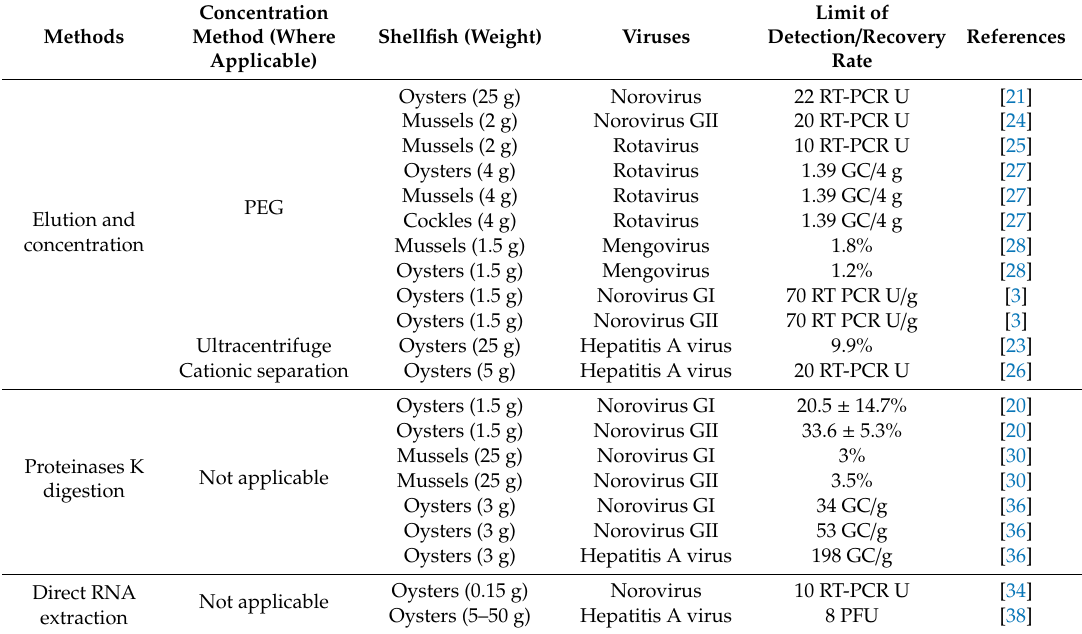
Table 1. Limit of detection or recovery rates (%) of viruses from shellfish using various methods.